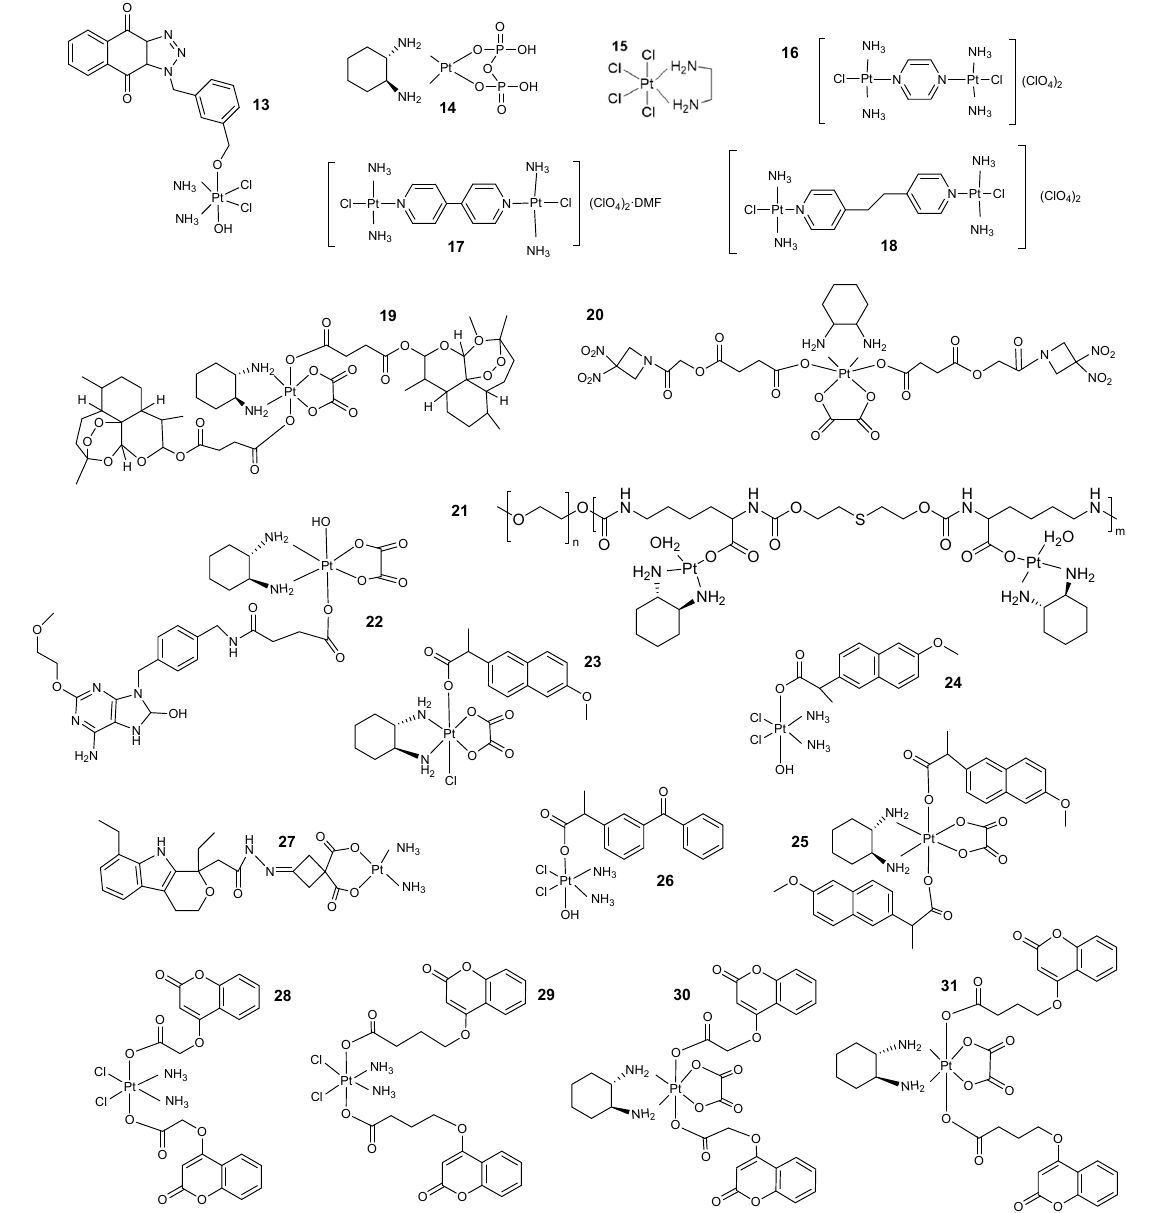
Figure 5. Synergistic involvement of Pt-based drugs in immunotherapy. ( 13 ) Pt(IV) complexes containing TDO inhibitors. ( 14 ) PT-112. ( 15 , 16 , 17 , 18 ) Four Pt complexes designed by Milos’s group. ( 19 ) The structure of OPA. ( 20 ) OXA-NO-enhanced immunotherapy designed by Liu’s group. ( 21 ) ROS-response micelles PKS. ( 22 ) Novel immunochemotherapeutic agents for the combination of TLR7 agonists with oxaliplatin. ( 23 ) Naproxen Pt(IV) complexes designed by Han’s group. ( 24 , 25 ) DNP and NP structures. ( 26 ) Ketoprofen Pt(IV) complex. ( 27 ) IA-1 structure. ( 28 , 29 , 30 , 31 ) A family of coumarin derivatives designed by Wang et al. Reprinted with permission from Ref. [42,43,49- 51,53,56,59,61-63].